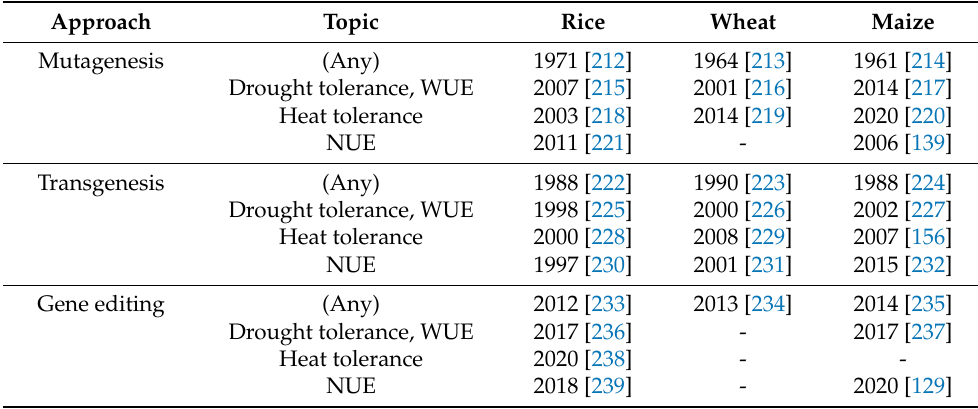
Table 3. Year and bibliographic reference of the first documented use of mutagenesis, transgenesis and gene editing tools in rice, wheat, and